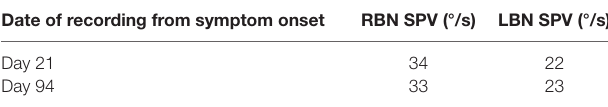
taBle 1 | Peak slow phase velocity (SPV) of the right-beating nystagmus (RBN) and left-beating nystagmus (LBN) component of the periodic alternating nystagmus before and after treatment with baclofen 90 mg three times daily. Date of recording from symptom onset